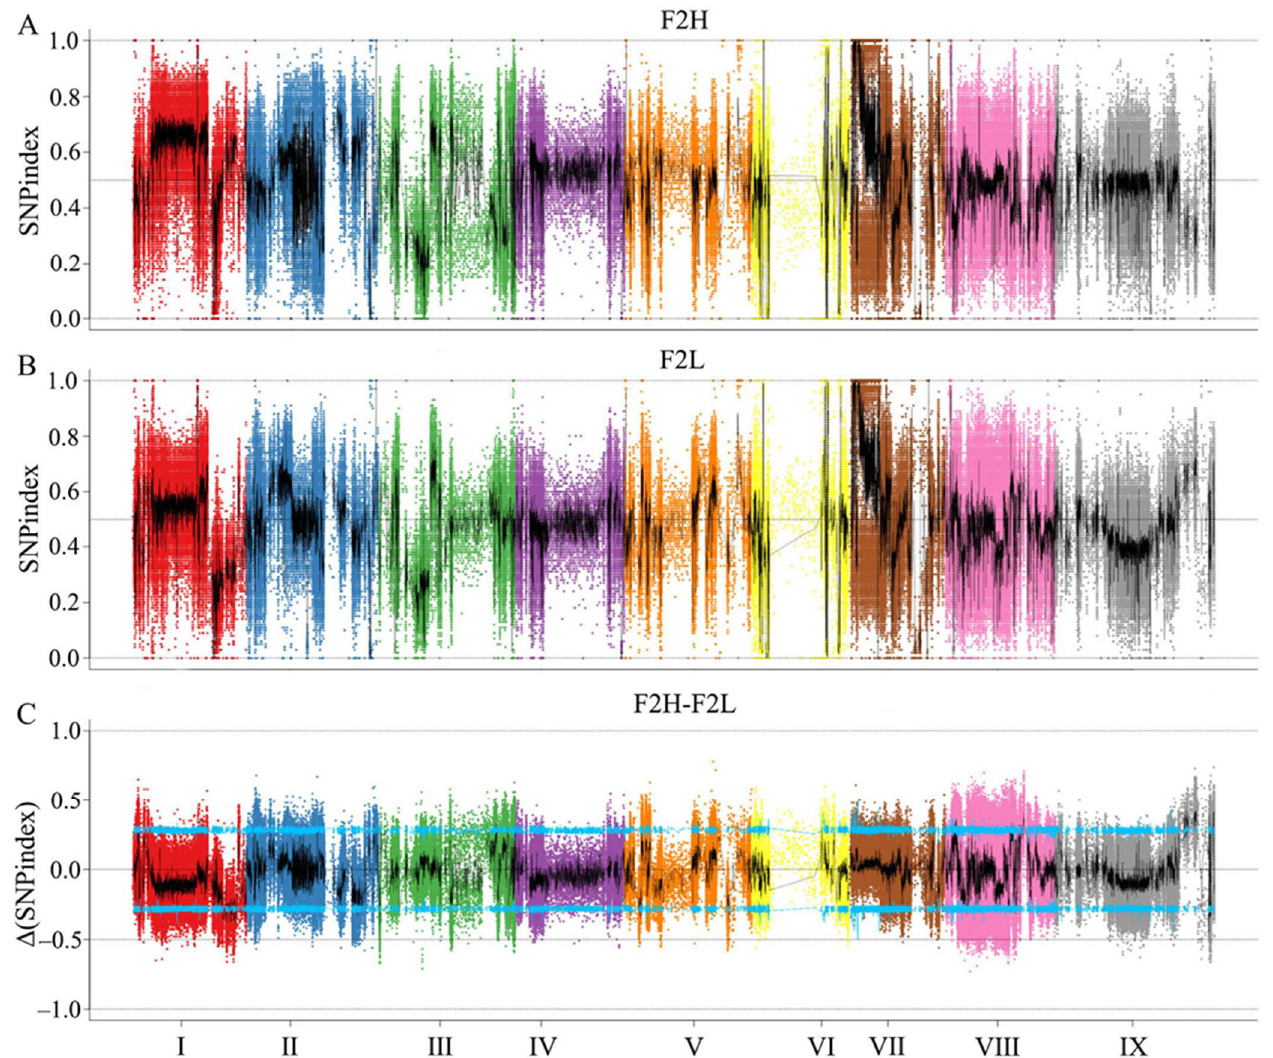
Figure 2. Distribution of SNP index association values on chromosomes. ( A ) Distribution of SNP- index values of F2H bulk on chromosomes. ( B ) Distribution of SNP index values of F2L bulk on chromosomes. ( C ) Distribution of Δ (SNP index) value on chromosomes, where the blue line represents the 95% CI. Table 2. The statistics of mapping results for